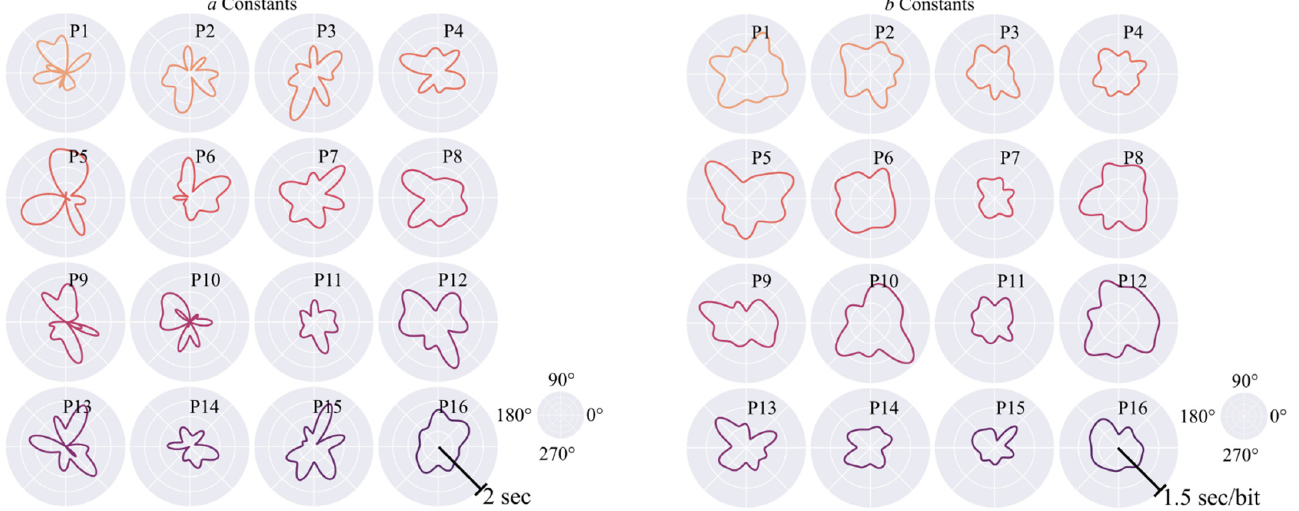
Figure 5. Fitts’ Law constants a and b for each participant. Constants a ( left ) and b ( right ) interpolated throughout the range of motion for participants (e.g., P1) for session 5.